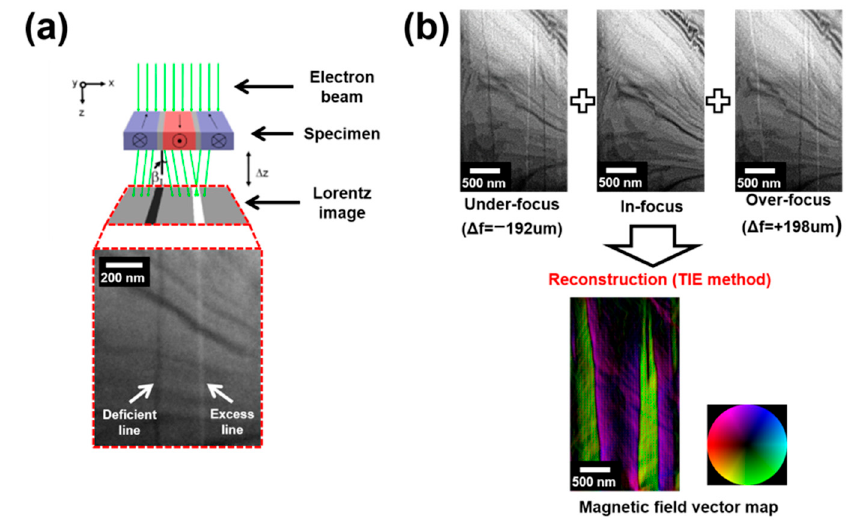
Figure 2. ( a ) Schematic of a ray diagram showing the paths of electrons passing through a magnetic specimen (upper), together with the magnetic domain or domain wall contrast for the Fresnel modes (lower). ( b ) The schematic diagram for imaging the in-plane magnetic configurations using Lorentz TEM. Three images were acquired in the same region under three different defocus conditions. The in-plane magnetization distribution map could be generated from the TIE method. The color wheel represents the magnetization direction at every point.